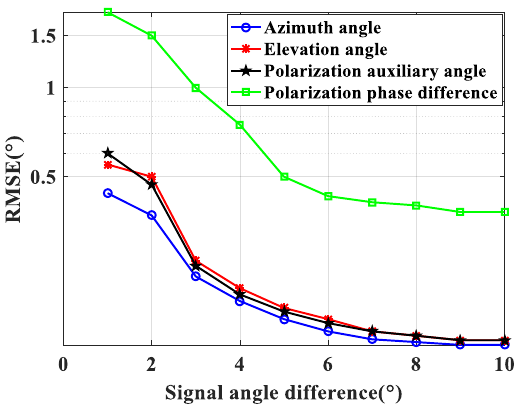
Figure 6. Estimation bias of the proposed algorithm: SNR = 20 dB, snapshot number = 1000,